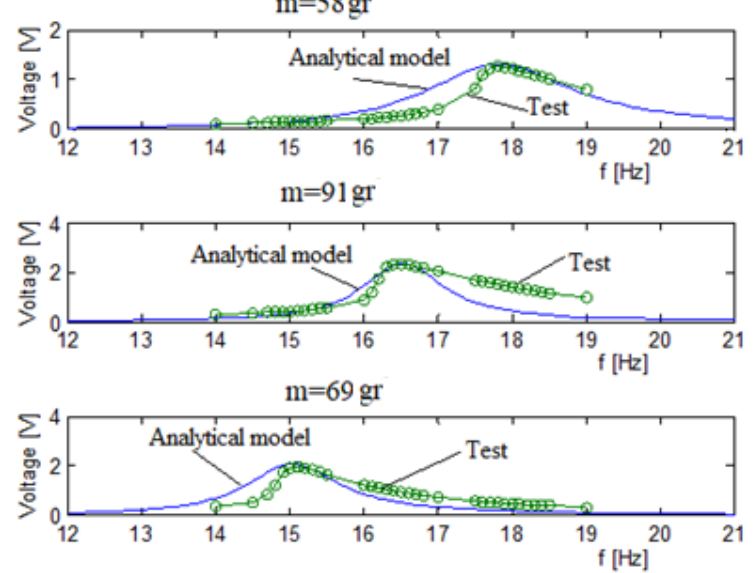
Figure 9. Three bimorphs without spring connection output voltage ‐ tests validation. Table 1. Three bimorphs system without spring connections ‐ stiffness and Q factors. Bimorph No.